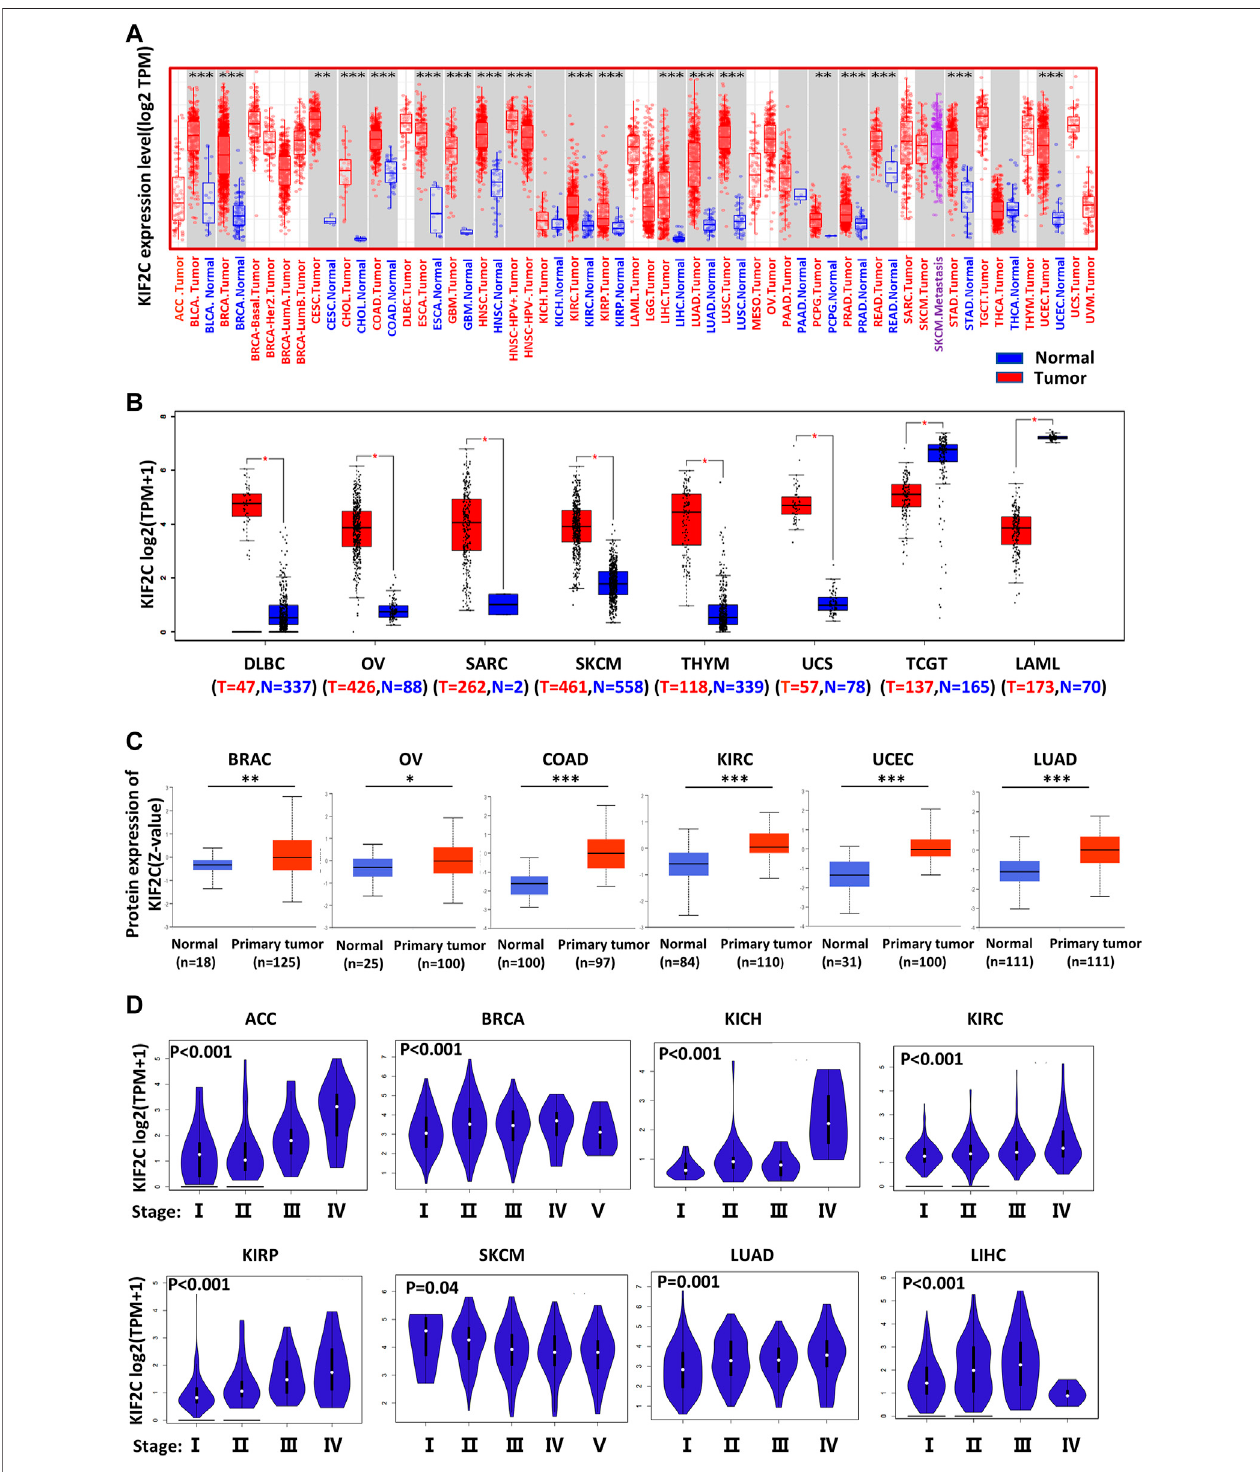
FIGURE1| Differentexpressionof KIF2C invarioustumorsandpathologicalstages. (A) KIF2C expressionin33tumortypesandparacancertissuesdeterminedby TIMER. (B) Tumor types of DLBC, OV, SARC, SKCM, THYM, UCS, TGCT, and LAML were analyzed by box plot, for which corresponding normal tissues of GTEx database were included as controls. (C) Diagrams ofquanti fi ed proteinsanalyzedby Clinical Proteomic Tumor Analysis Consortium in BRAC, OV, COAD, KIRC, UCEC, and LUAD. (D) Expression of KIF2C in different tumor stages. Log2 (TPM+1) was applied for log-scale. * p < 0.05; ** p < 0.01; *** p < 0.001.